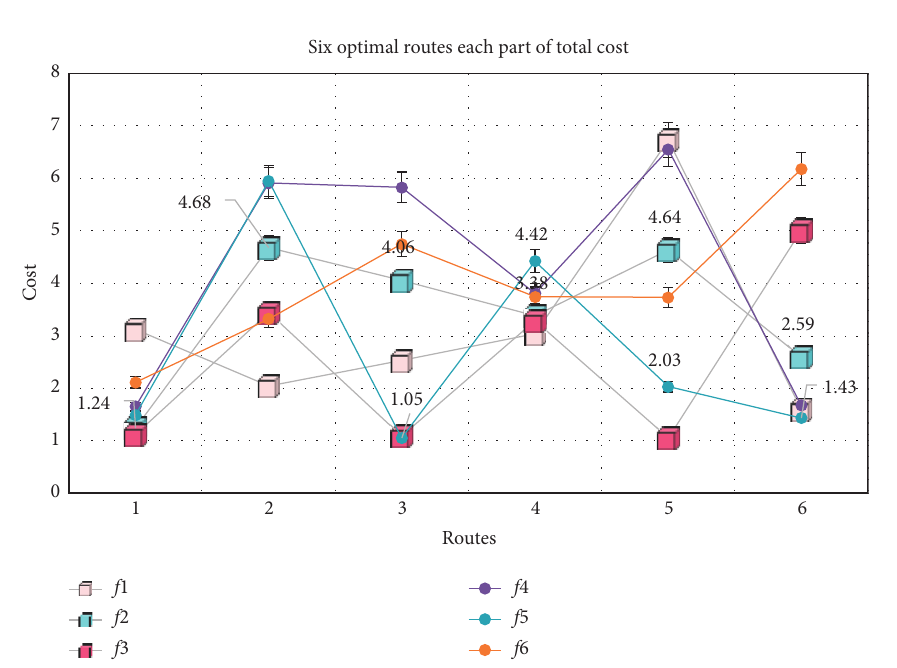
Figure 15: Six optimal routes of each part of total cost.